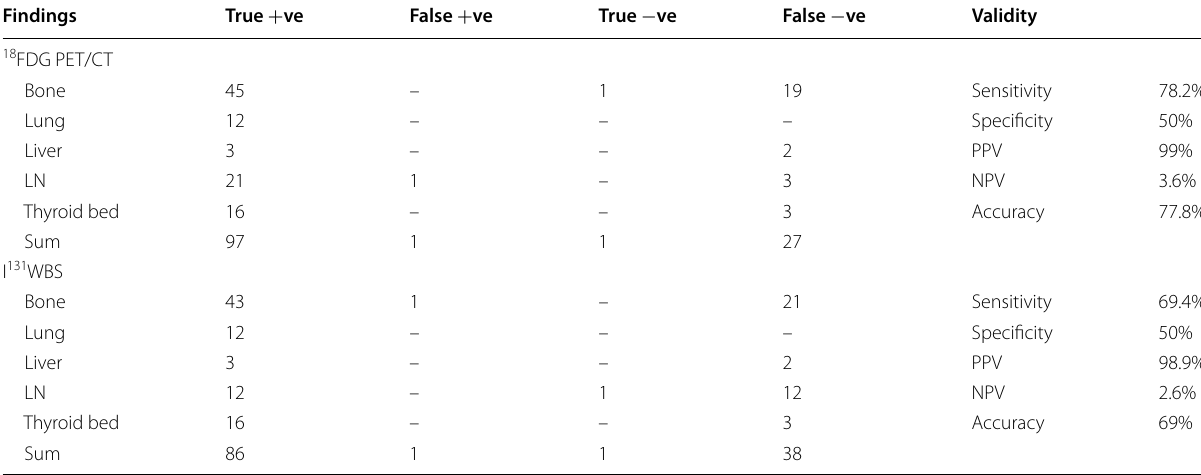
PPV, positive predictive value; NPV, negative predictive value